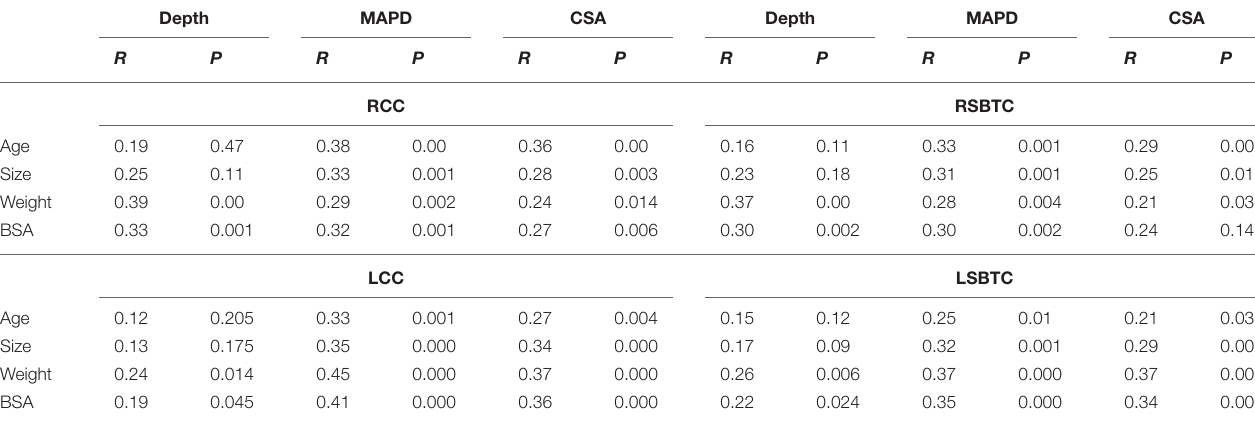
RCC,rightcricoidcartilage;RSBTC,rightsuperiorborderofthyroidcartilage;LCC,leftcricoidcartilage;LSBTC,leftsuperiorborderofthyroidcartilage;MAPD,maximalantero-posterior diameter; CSA, cross-sectional